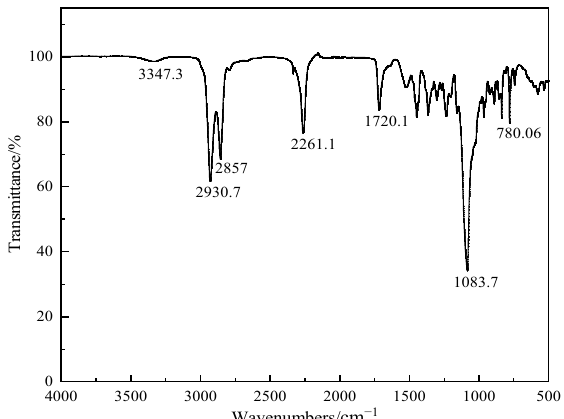
Figure 3. IR spectroscopy of the synthetic copolyether(dissolving with dichloromethane, then coating a thin film, resolution of 4 cm − 1 , spectral range of 350~4000 cm − 1 ).